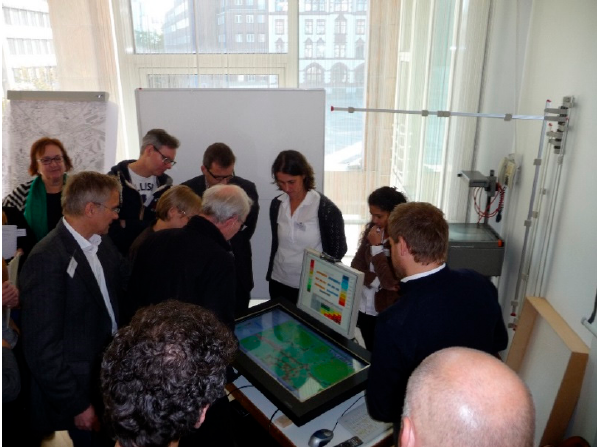
Figure 4. The MapTable as a shared workspace for supporting group work.